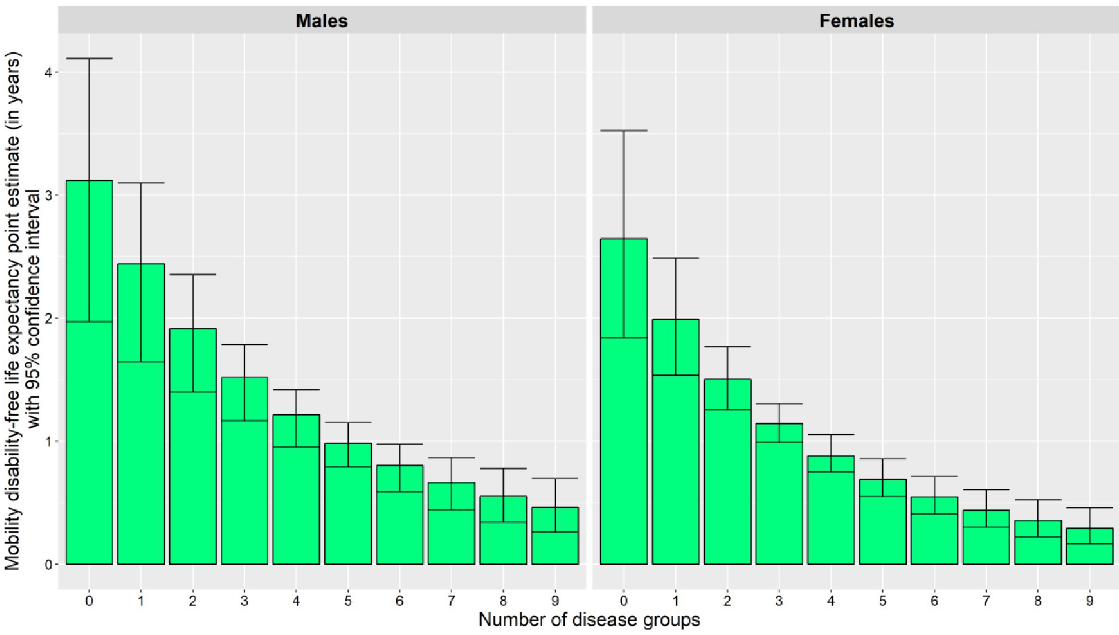
Fig 5. Graphical representation of point estimates with 95% confidence intervals for mobility disability-free life expectancy (in years) at each disease group count, in male and female participants at age 85.